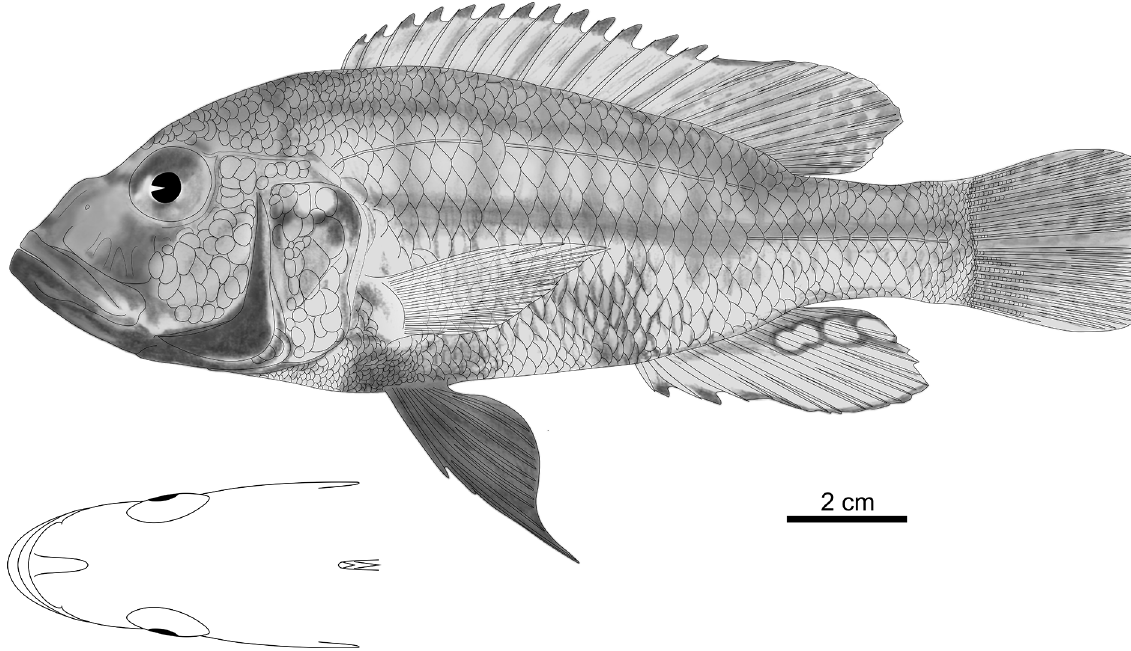
Fig. 23. Haplochromis kimondo sp. nov., holotype, ♂, 152.4 mm SL (RMCA 2019.002.P.0015). Drawn by N.